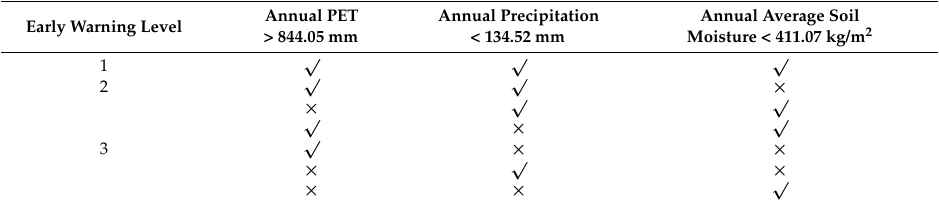
Table 7. The hydrological drought early warning